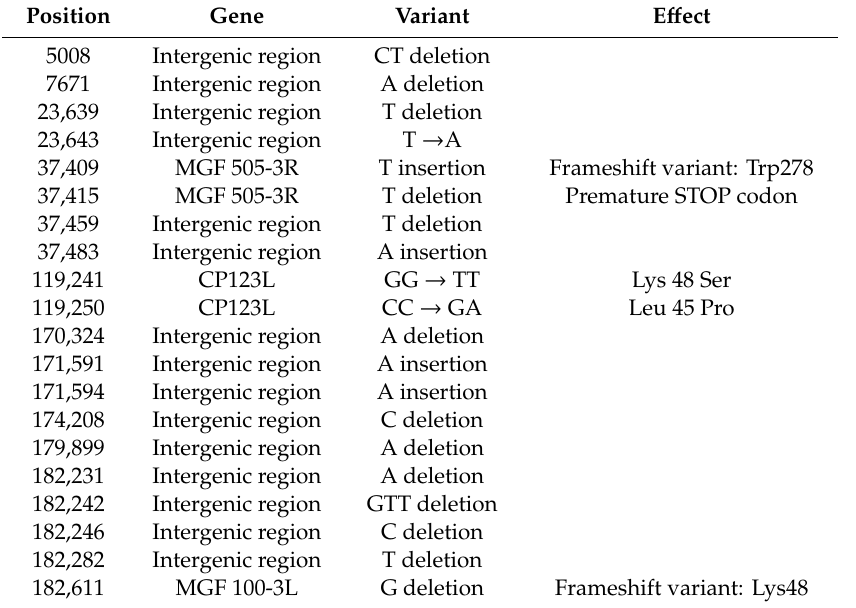
Table 9. Unique mutations observed in the alignment of ASFV Arm / 07 / CBM / c4 with the selected ASFV strains from Table 8 (in